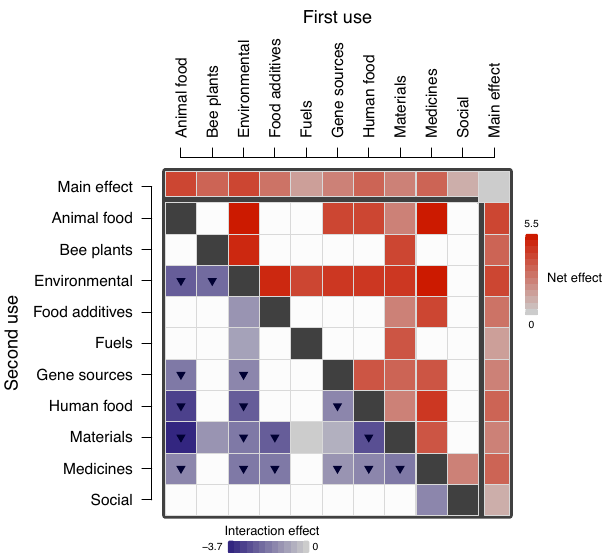
Fig. 4 Naturalization success of taxa with different combinations of two economic uses. Redish and bluish fi ll colors of the squares correspond to the magnitude of the coef fi cients from binomial GLMs for each pairwise combination of two economic uses (see Supplementary Table 3). The top row and right outermost column correspond to the main effects of each economic use, which, with the exception of fuels and social, were all signi fi cantly positive (all p < 0.001) compared with taxa with no economic use. The colors of the squares below the diagonal indicate the magnitude of the coef fi cients of the interaction term between both economic uses, which were all negative. Signi fi cant ( p < 0.05) interaction coef fi cients are indicated with a black downward pointing triangle. Signi fi cance of the coef fi cients was determined with two-sided z -tests without correction for multiple comparisons. The colors of the squares above the diagonal (not including the top row and the right outermost column) indicate the magnitude of the net effect of the main and interactive effects of the two economic uses. Main effects for invertebrate food and non-vertebrate poisons are not shown, because each of their combinations with other economic use classes included fewer than ten taxa, resulting in high uncertainties of the estimates or no data. For the same reason, combinations of two economic uses that included fewer than ten taxa are also not shown (i.e., white